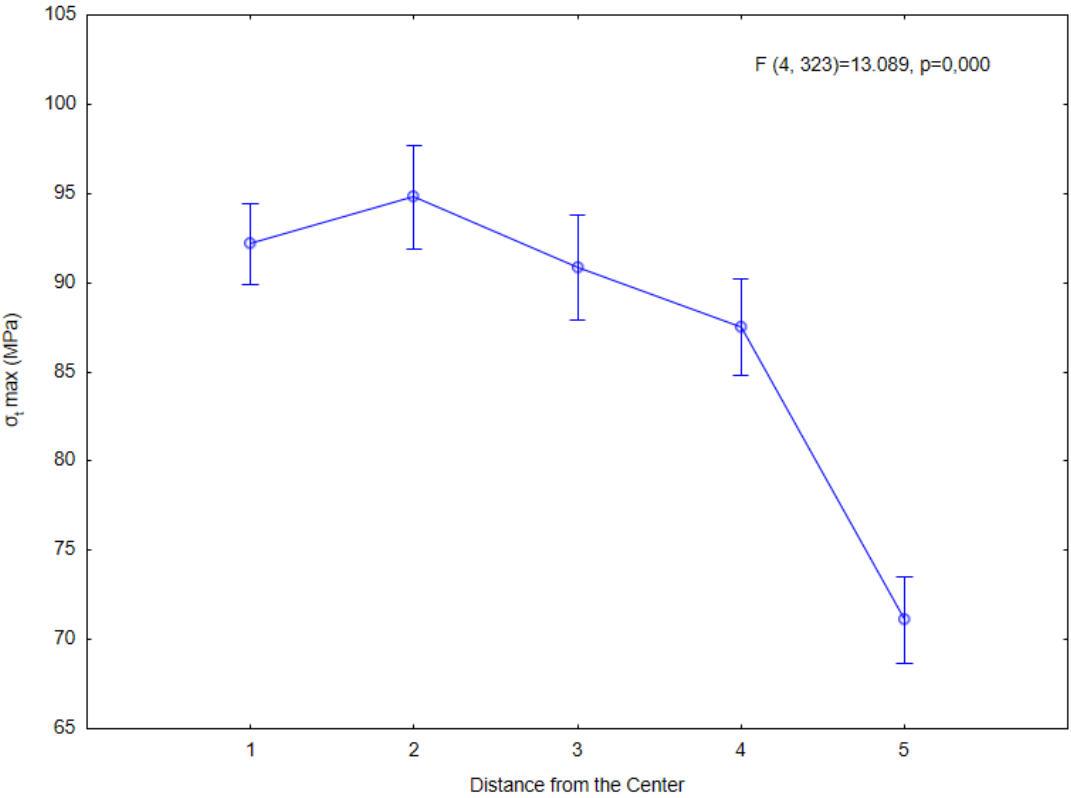
Figure 5. Statistical evaluation of the effect of distance from center on tensile strength using ANOVA .